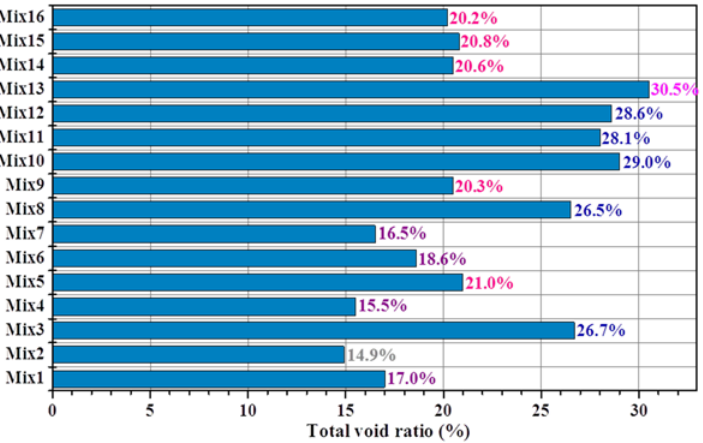
Figure 4. ( a ) Response surface and ( b ) contour line of 28 ‐ day compressive strength versus PF and P/A ratio.